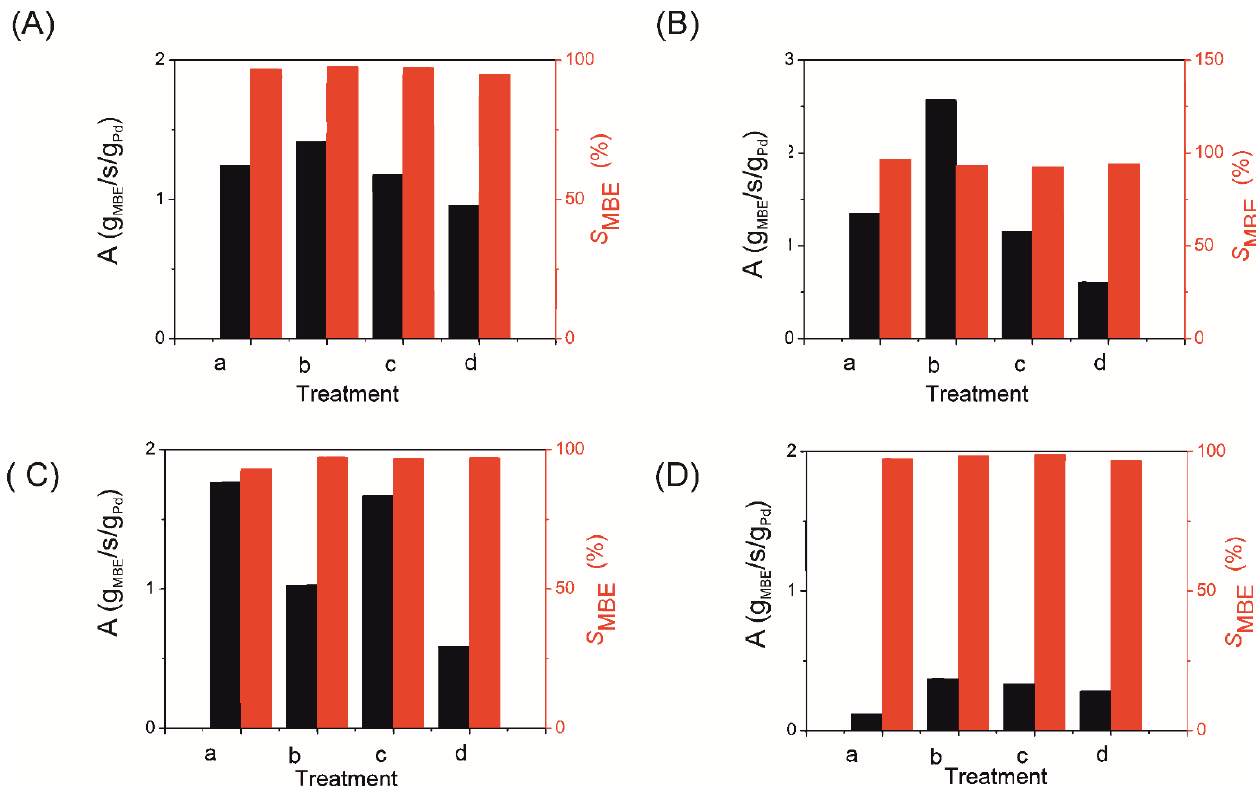
Figure 7. The effect of time on stream and activation conditions on activity and selectivity in the hydrogenation of MBY on coatings ( A ) PdZn/TiO 2 , ( B ) PdZn/Ti 0.8 Zr 0.2 O 2 , ( C ) PdZn/Ti 0.95 Ce 0.05 O 2 , ( D ) PdZn/Ti 0.8 Zn 0.2 O 1.8 . Black rectangle—activity (A) and red rectangle—MBE selectivity (S MBE